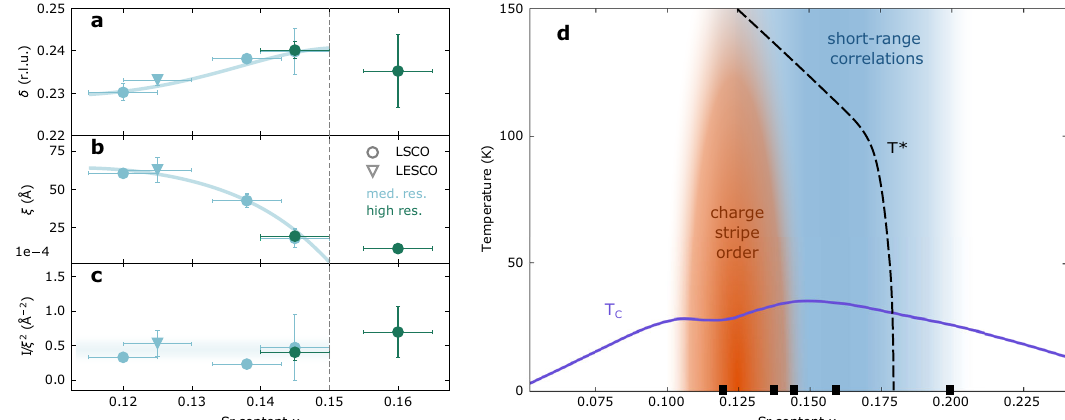
Fig. 4 Charge order parameters and phase diagram. a – c Charge order incommensurability δ , correlation length ξ (de fi ned as the inverse half-width-half-maximum) and integrated diffracted intensity (amplitude I divided by ξ 2 ) versus hole doping for LSCO (circles) and LESCO (squares) at base temperature. The parameters were extracted from fi ts to elastic scans, see Supplementary Fig. 4. Error bars re fl ect the standard deviation obtained from the fi ts. Data for LSCO x = 0.12 are from ref. 53 and for LESCO x = 0.125 from ref. 27 . All colored lines are guides to the eye. Vertical dashed line in a – c marks the critical doping separating long- from short-range correlations. d Schematic charge order phase diagram: temperature versus hole doping/Sr content x . Superconducting dome and pseudogap onset of LSCO are illustrated by respectively solid violet and dashed black line 21,26,35 . Red and blue phases indicate respectively long-range and short-range charge correlations. Solid squares indicate the doping compositions studied in this